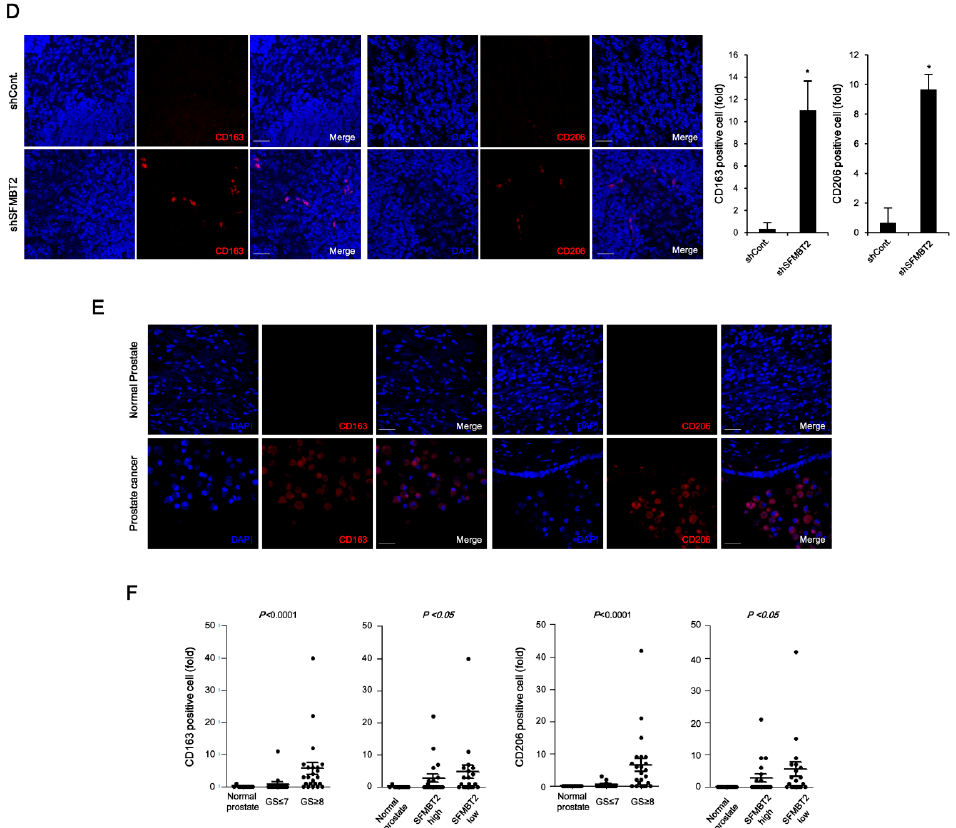
Figure 2. Down-regulation of SFMBT2 induces an increased number of preadipocytes and tumor-associated macrophages (TAMs) in prostate cancer. ( A ) Increased number of preadipocytes in prostate cancer induced by intraprostatic injection of LNCaP cells stably transfected with SFMBT2 shRNA. LNCaP cells (1 × 10 6 cells) transfected stably with control (shCont) or SFMBT2 shRNA (shSFMBT2) were injected into the dorsal lobe of the prostate of nude mouse (n = 3 / group). At week 5 post-injection, the prostate was harvested, fixed, sectioned, and immunostained with anti-Pref-1 and anti-CD29 antibodies. Representative images are shown. Nuclei were identified using DAPI staining. Scale bar, 25 µ m. Pref-1 or CD29 positive cells were counted. ( B ) Increased expression of Pref-1 and anti-CD29 in prostate cancer tissues of patients. Immunohistochemical staining of a tissue array from prostate cancer patients was performed using anti-Pref-1 and anti-CD29 antibodies. Representative images are shown. Nuclei were identified using DAPI staining. Scale bar, 25 µ m. ( C ) Proportional relationship of Gleason scores (GS) with the number of Pref-1 or CD29 positive preadipocytes in prostate cancer tissues of patients. Inverse relationship of SFMBT2 expression with a number of Pref-1 or CD29 positive preadipocytes in prostate cancer tissues of patients. ( D ) Increased number of TAMs in prostate cancer induced by intraprostatic injection of LNCaP cells stably transfected with SFMBT2 shRNA. LNCaP cells (1 × 10 6 cells) transfected stably with control or SFMBT2 shRNA were injected into the dorsal lobe of the prostate of nude mice (n = 3 / group). At week 5 post-injection, the prostate was harvested, fixed, sectioned, and immunostained with anti-CD163 and anti-CD206 antibodies. Representative images are shown. Nuclei were identified using DAPI staining. Scale bar, 25 µ m. CD163 or CD206 positive cells were counted. ( E ) Increased expression of CD163 and CD206 in prostate cancer tissues of patients. Immunohistochemical staining of a tissue array from prostate cancer patients was performed using anti-CD163 and anti-CD206 antibodies. Representative images are shown. Nuclei were identified using DAPI staining. Scale bar, 25 µ m. ( F ) Proportional relationship of Gleason scores with the number of CD163 and CD206 positive TAMs in prostate cancer tissues of patients. Inverse relationship of SFMBT2 expression with a number of CD163 and CD206 positive TAMs in prostate cancer tissues of patients. All data represent mean ± S.E.M. Significance values were * p ≤ 0.05 and ** p ≤